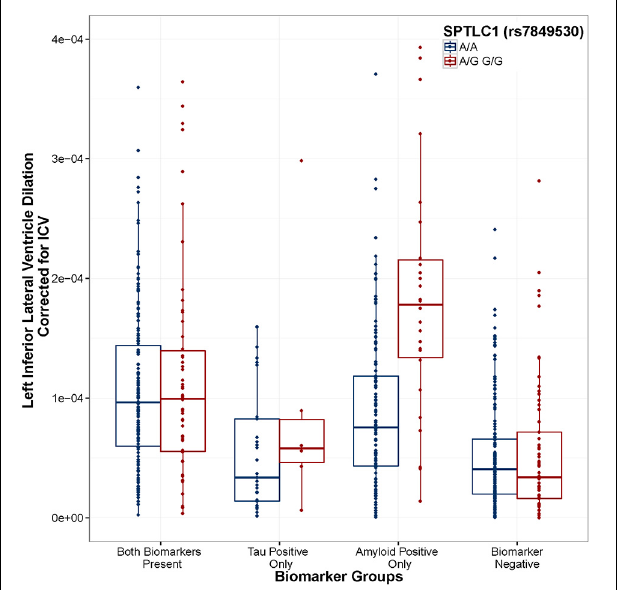
FIGURE 2 | SPTLC1 (rs7849530) modifies the association between amyloid positivity and ventricular dilation. Biomarker groups are presented on the x-axis and annual change in the left inferior lateral ventricle is presented on the y-axis. Boxplots are grouped by rs7849530. G is the minor allele. When controlling for Age, Gender, Education, Diagnosis, and ICV, the amyloid_positive × rs7849530 interaction was statistically significant ( t = 6 . 39, p = 3 . 14 × 10 − 10 ). In the amyloid-only biomarker group, carriers of the G allele showed a greater rate of ventricular dilation than homozygous carriers of the A allele ( t = 5 . 306, p < 0 . 001). Model: